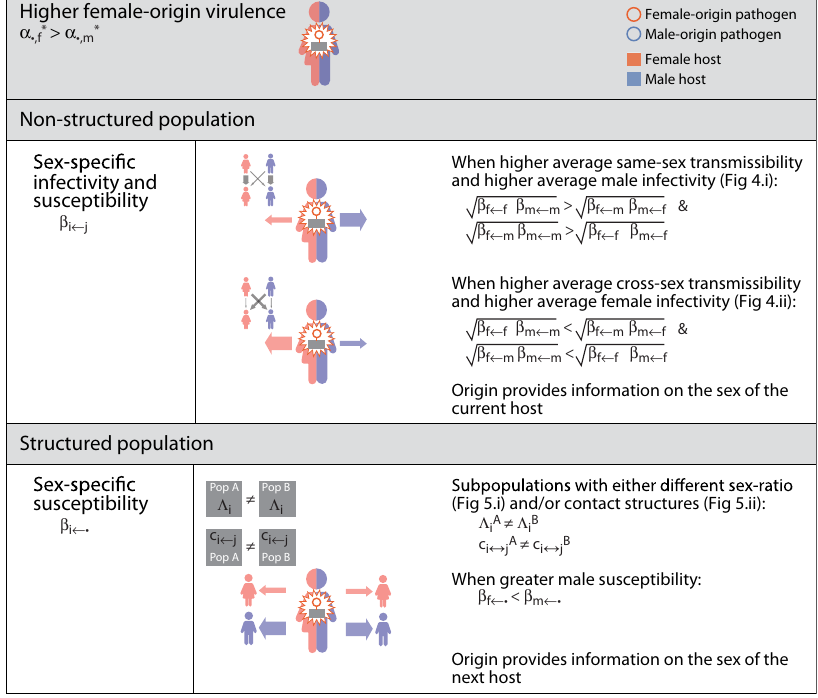
Fig. 8 Summary of results regarding the evolution of origin-speci fi c virulence. We focus on the case when female-origin virulence will be greater than male-origin one. Each row indicates a set of different assumptions regarding the population structure and pathogen ’ s transmissibility.